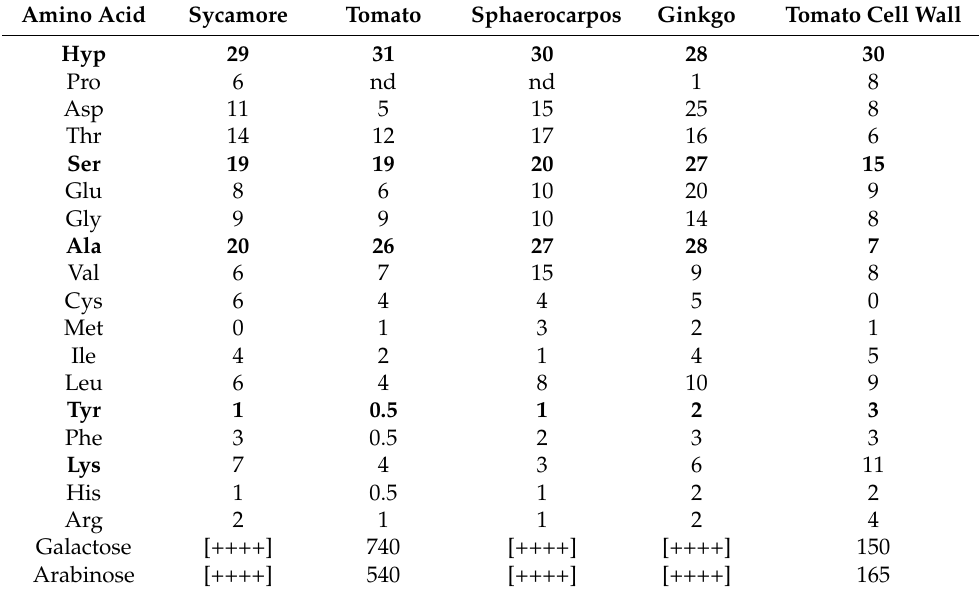
Galactose Arabinose 165 ++++: these sugars were highly